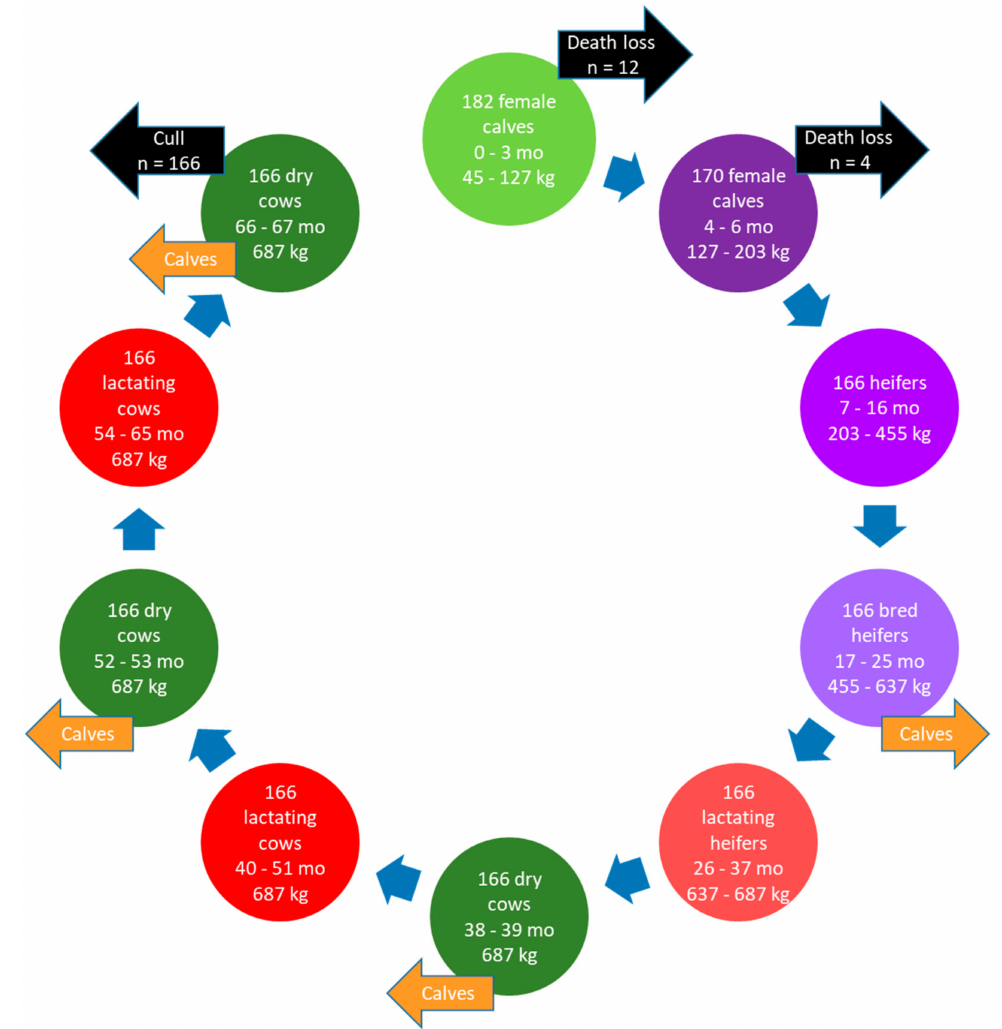
Figure 2. Life cycle of a dairy herd in Alberta illustrating the herd dynamics over time for dairy cows with a productive lifespan of three